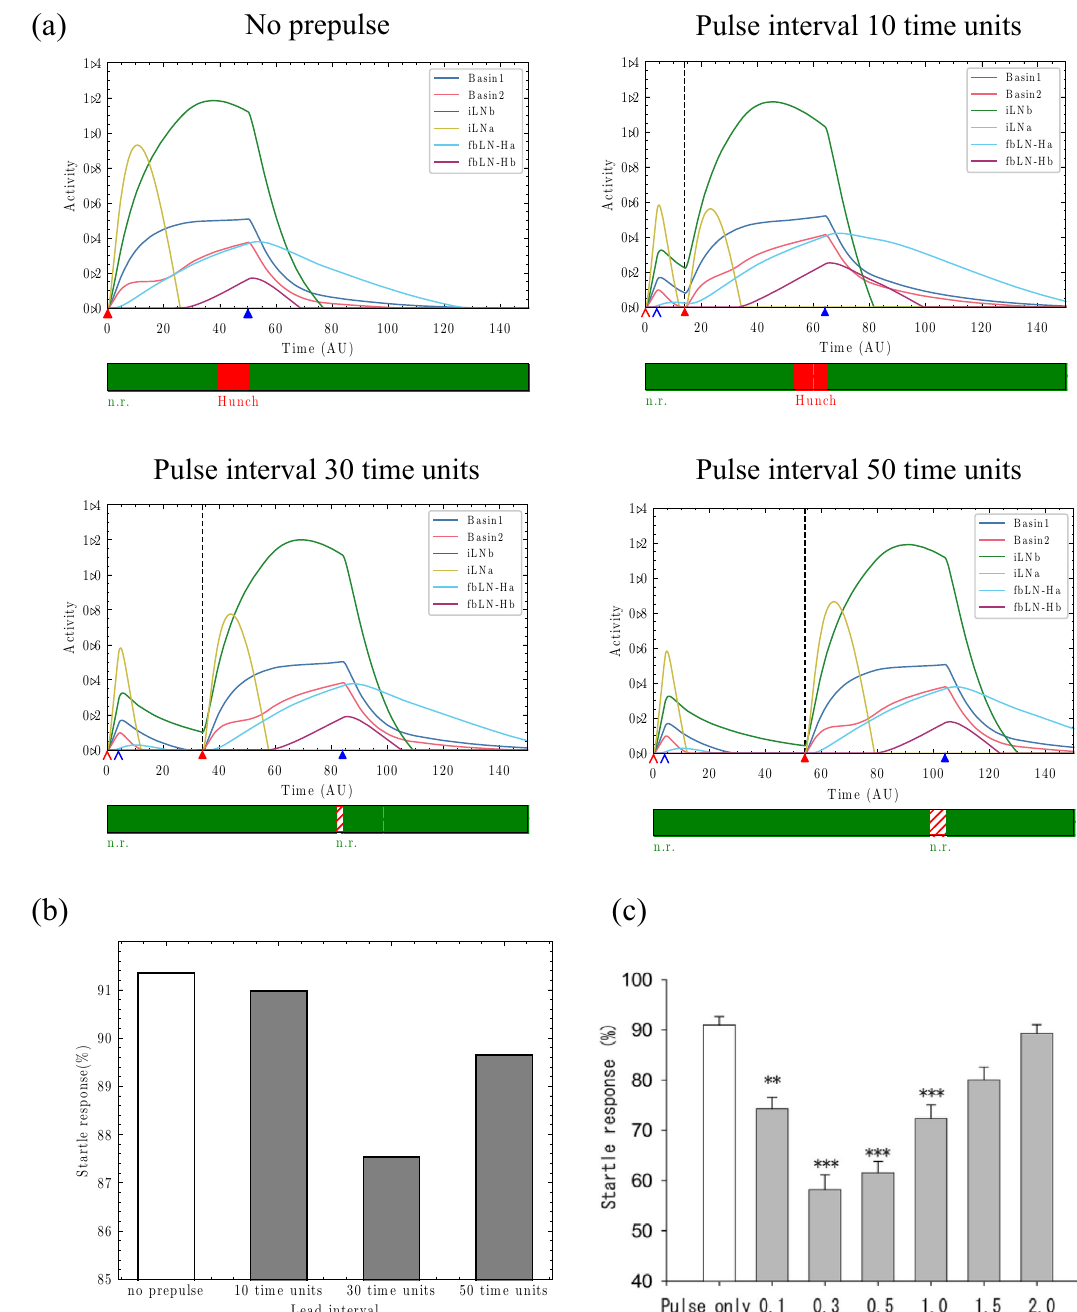
Figure 4. Dependence of PPI on the lead interval. ( a ) Temporal changes in neuron activity ( w iLNa = 1.10, w iLNb = 2.40 ) as the lead interval changed. Upper left: Without a prepulse. Upper right: Lead interval of 10 time units. Lower left: Lead interval of 30 time units. Lower right: Lead interval of 50 time units. A vertical dashed black line indicates the time of the pulse input. The thin arrow head pointing to the horizontal axis indicates the prepulse timing, and the thick arrow head indicates the pulse timing. The red and blue colours indicate the onset and offset times, respectively. The colours in the band below each graph indicate the behaviour at the corresponding time. Green: n.r. Red: hunch. Behaviours indicated by the striped lines are classified as n.r. because their duration was shorter than the cut-off time (10 time units). ( b ) Changes in percentages of the startle response in the behavioural landscape due to changes in the lead interval. ( c ) Behavioural experimental results of changes in the startle response due to changes in the lead interval. Reprinted from Matsumoto et al . 31 Fig.